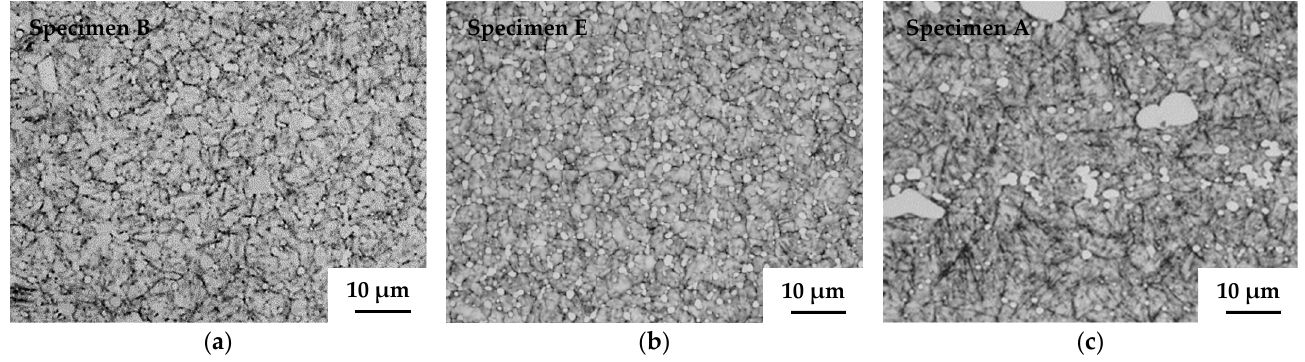
Figure 8. Microstructure of specimens B, E, and A. Size of grains and precipitates between specimens B and E did not differ significantly. In contrast, grains and precipitates of specimen A were larger than those of specimen E. ( a ) 1503 K sintering; ( b ) 1463 K sintering with S–HIPping; ( c ) cast–forged material.